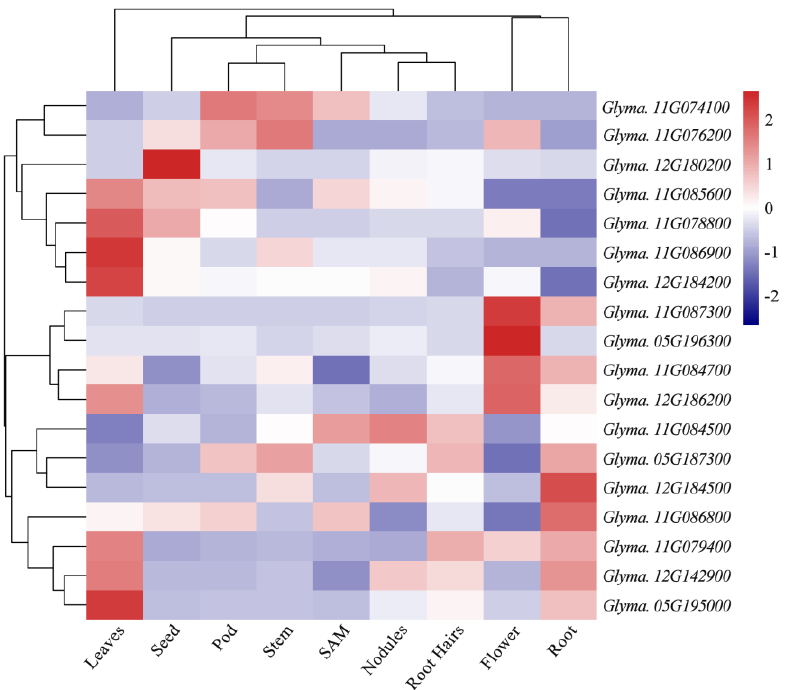
Figure 4. Heatmap profiles of the candidate genes in tissues. The color scale represents increased (red) and decreased (navy blue) fold change in the levels of candidate genes transcripts. The horizontal axis represents different soybean tissues (leaves, seed, pod, stem, SAM, nodules, root hairs, flower, and root), and the vertical axis stands for different candidate genes.